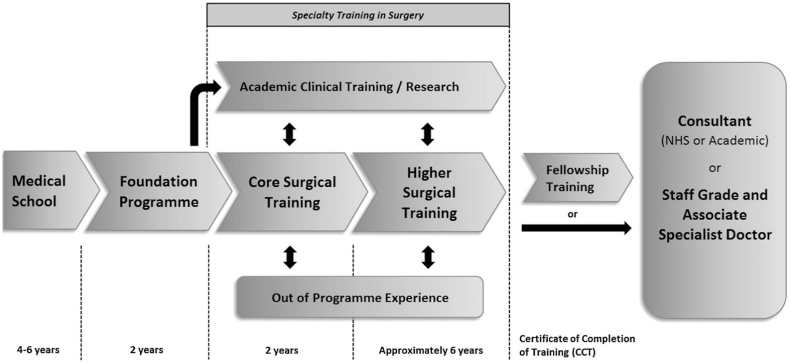
Surgical training pathway in the UK [2].